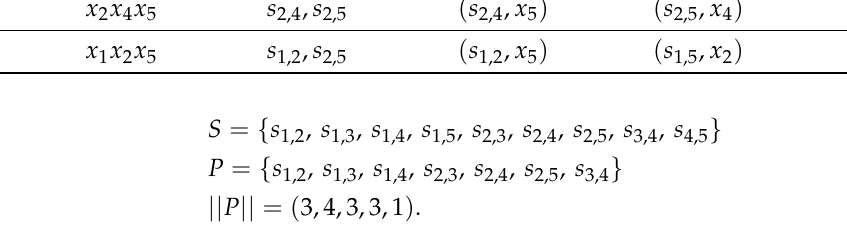
( s ) ( s 2,5 , x 4 4,5 , x 2